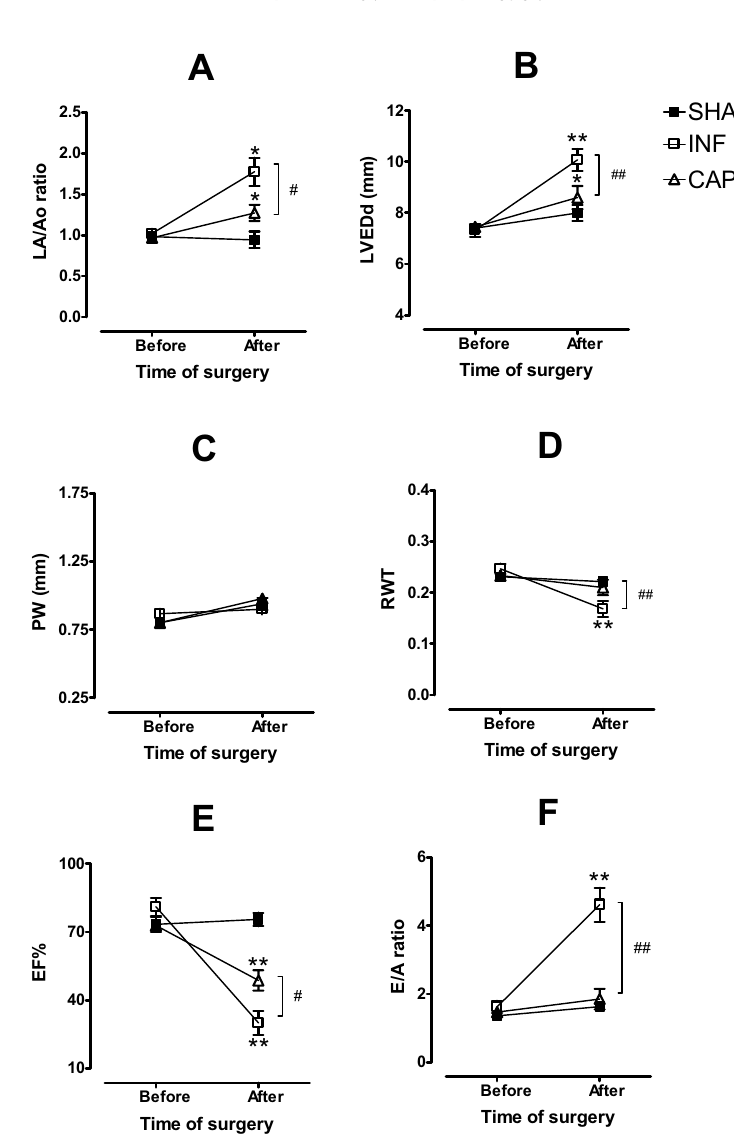
Fig. 1 – Echocardiographic parameters recorded from SHAM, INF and CAP just before and21daysaftersurgery. Leftatrium-to-aortadiameter(LA/Ao)ratio(A),leftventricular end-diastolic diameter (LVEDd, B), posterior wall thickness in diastole (PW, C), relative wall thickness (RWT, D), ejection fraction (EF%, E) and E/A velocity ratio (E/A ratio, F). Data are means ± SEM. *P < 0 . 05 and **P < 0 . 01 vs. before and # P < 0 . 05 and ## P < 0 . 01 CAP vs.